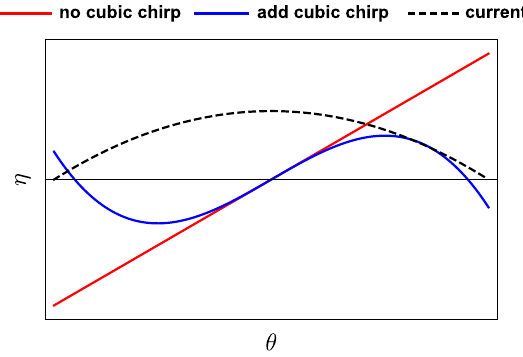
FIG. 1. Generic schematic that illustrates the chirp profile of the electron beam vs the current profile.